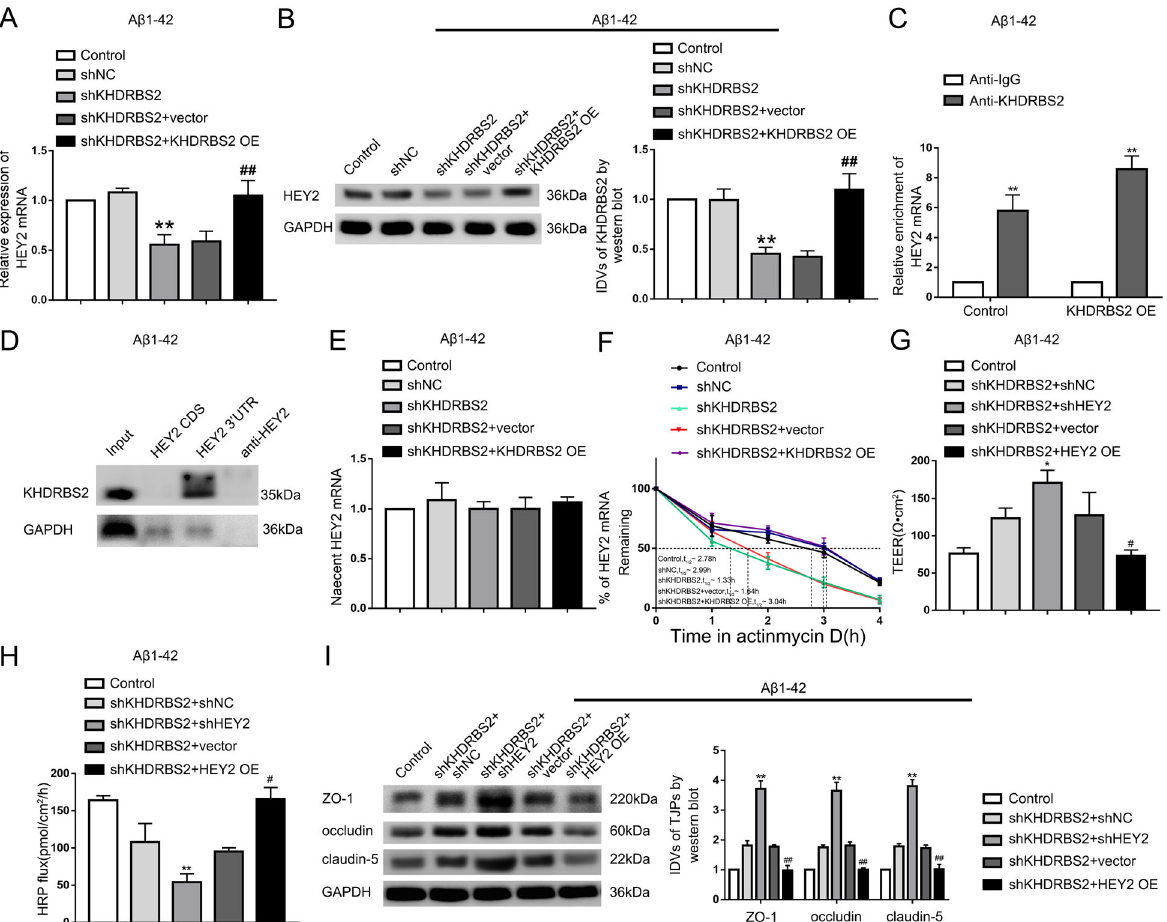
Fig. 5 KHDRBS2-regulated BBB permeability by increasing the half-life of HEY2 mRNA in A β 1 – 42 microenvironment. A Effects of KHDRBS2 on HEY2 mRNA expression in ECs pre-incubated with A β 1 – 42 by qRT-PCR. B Effects of KHDRBS2 on HEY2 protein expression in ECs pre- incubated with A β 1 – 42 by western blot. Data are presented as mean ± SD ( n = 3, each). ** P < 0.01 versus shNC group. ## P < 0.01 versus shKHDRBS2 + vector group. C RNA immunoprecipitation con fi rmed the bonding between KHDRBS2 and HEY2 mRNA in A β 1 – 42 microenvironment. Relative enrichment was measured by qRT-PCR. Data are presented as mean ± SD ( n = 3, each). ** P < 0.01 versus Anti- IgG group. D Western blot of the proteins from HEY2 CDS, HEY2 3 ′ UTR, and antisense HEY2 pull-down assays in A β 1 – 42 microenvironment. E Nascent HEY2 levels in A β 1 – 42 -incubated ECs by qRT-PCR. Data are presented as mean ± SD ( n = 3, each). F The graph shows HEY2 levels in ECs pre-incubated with A β 1 – 42 at different times treated with ActD in the Control, shNC, shKHDRBS2, shKHDRBS2 + vector, and shKHDRBS2 + KHDRBS2 OE groups by qRT-PCR. G , H Effects of KHDRBS2 knockdown and HEY2 on TEER values G and HRP fl ux H in A β 1 – 42 microenvironment. I Effects of KHDRBS2 knockdown and HEY2 on ZO-1, occludin, and claudin-5 expression levels in A β 1 – 42 -incubated ECs by western blot. Data are presented as mean ± SD ( n = 3, each). * P < 0.05 versus shKHDRBS2 + shNC group, ** P < 0.01 versus shKHDRBS2 + shNC group, # P < 0.05 versus shKHDRBS2 + vector group, ## P < 0.01 versus shKHDRBS2 + vector